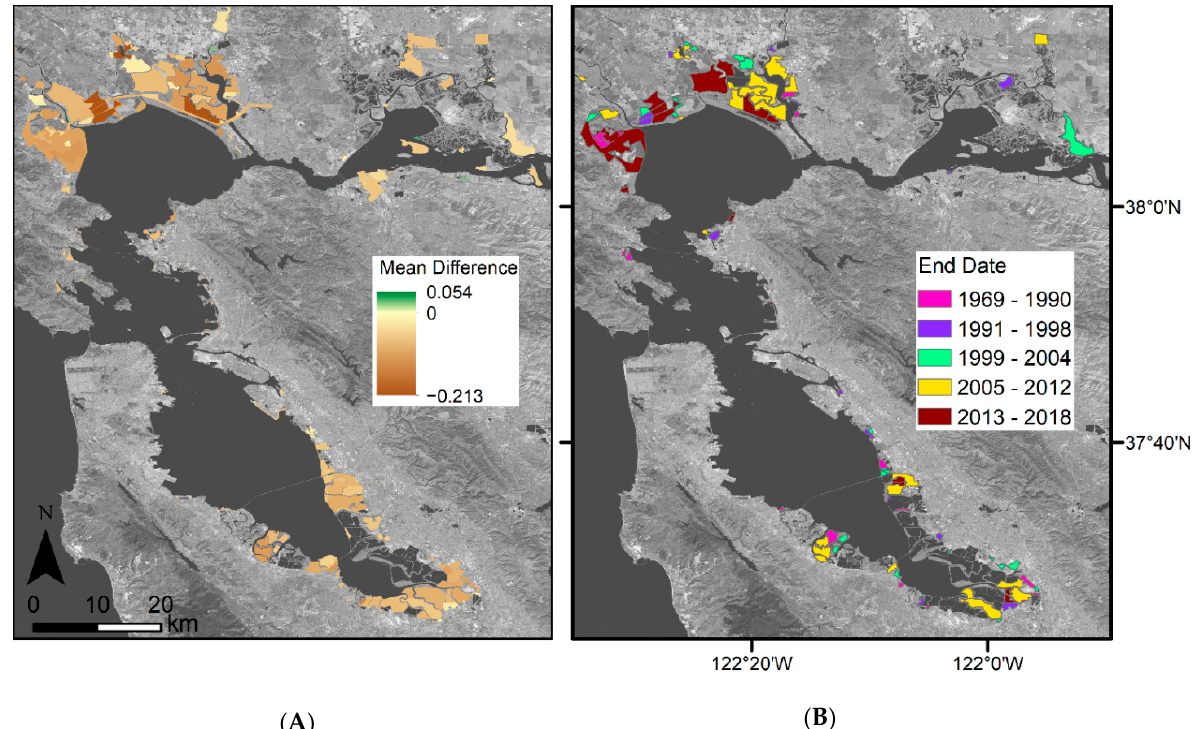
Figure A1. The three Landsat tiles that overlap our study area. Bay Area wetlands are highlighted in red. The main Landsat tile, WRS-2 path 44, row 34, is outlined in purple, while additional Landsat tiles that cover parts of San Pablo Bay and Suisun Bay are outlined in blue (WRS-2 path 45, row 33) and orange (WRS-2 path 44, row 33). Basemap: Landsat 8, U.S. Geological Survey.